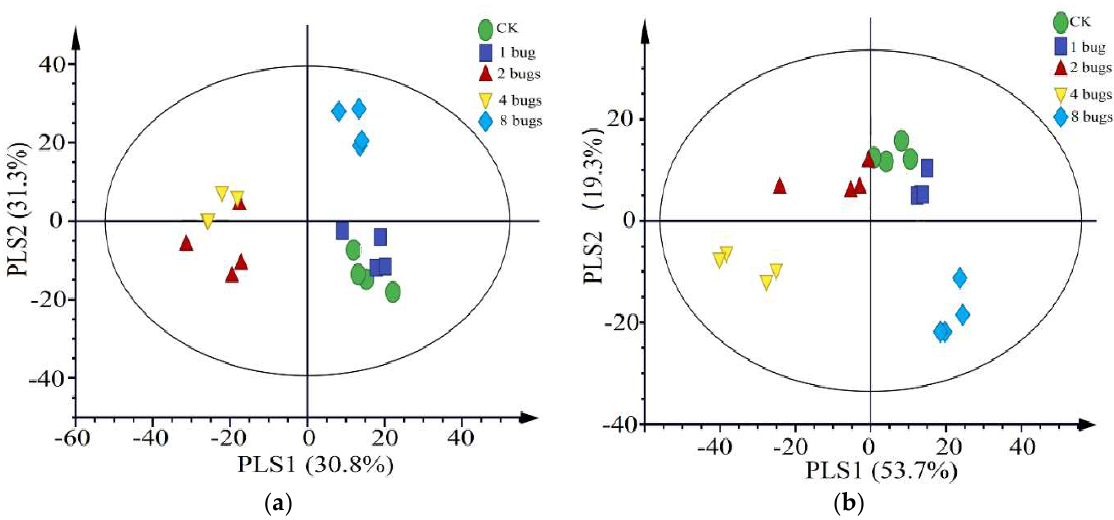
Figure 3. Partial least squares discriminant analysis (PLS-DA) of cotton plants volatile compounds. The cotton plants were either uninfested (Control), infested with one miridae (one bug), two miridae (two bugs), four miridae (four bugs), or eight miridae (eight bugs). The score plot displays the grouping pattern according to the first two components, and the ellipse defines Hotelling’s T2 confidence interval (95%) for the observations. ( a ) HIPVs collected at the period from 17:00 p.m. to 21:00 p.m.; ( b ) HIPVs collected at the period from 10:00 a.m. to 14:00 p.m.